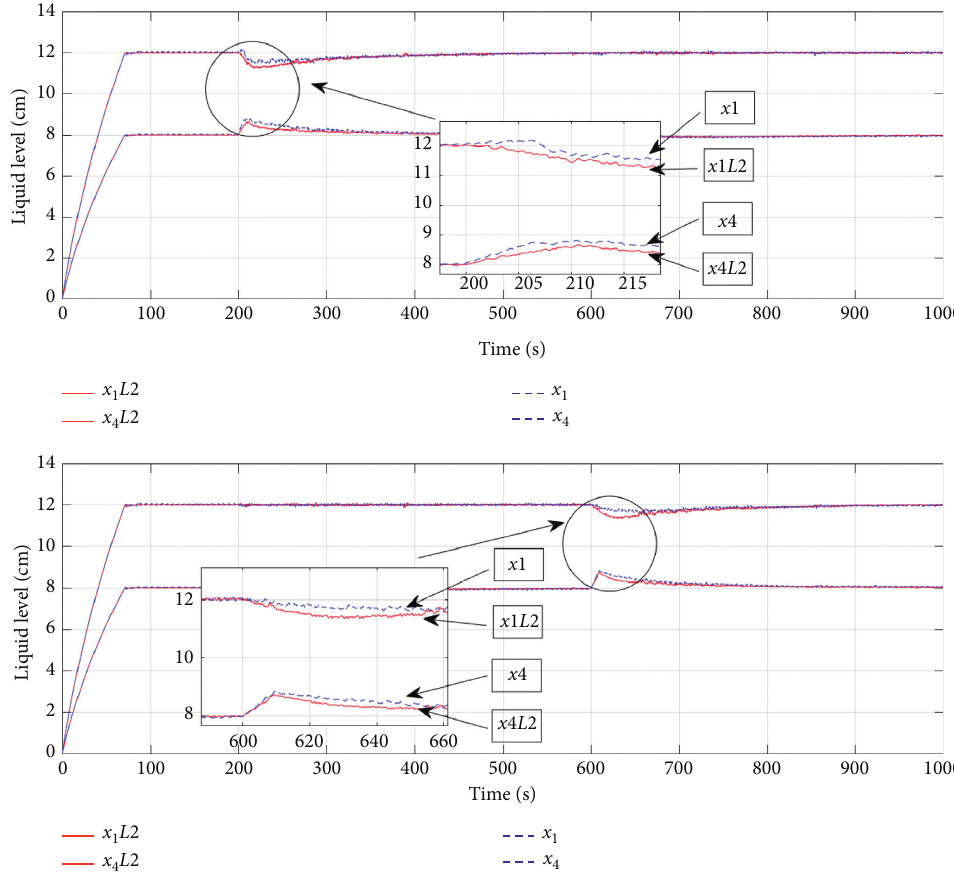
disturbance attenuation control 2